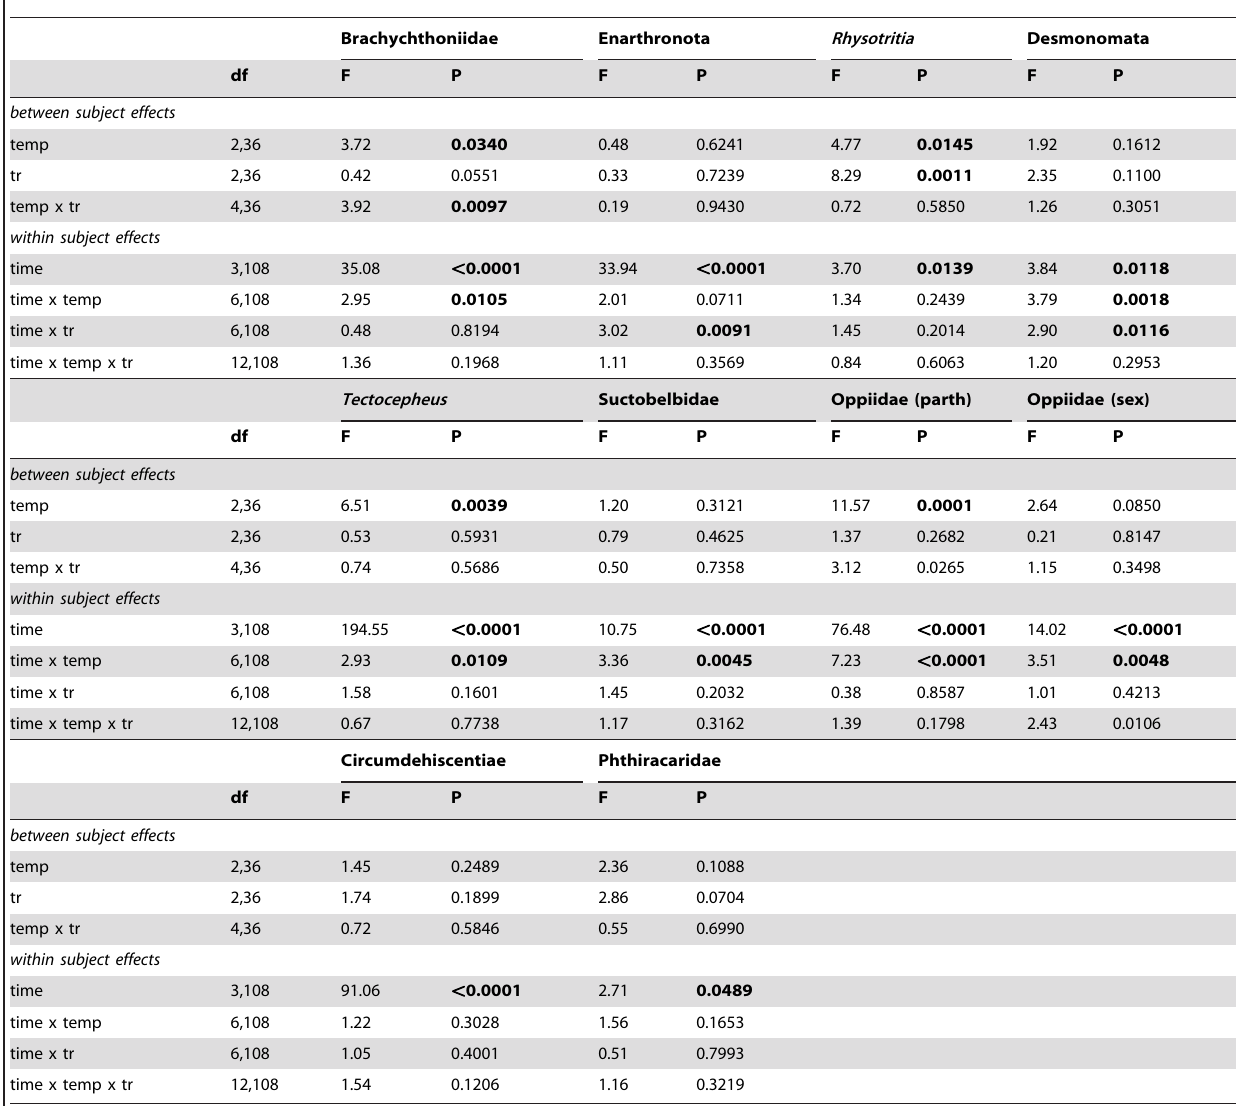
Table 1. F- and P-values on the effect of time (2, 10, 20 and 44 weeks), temperature (temp; 10, 15, 20 u C) and treatment (tr; control, reduced litter quality and glucose addition) of the density of ten pooled oribatid mite groups analyzed by repeated measures analysis of